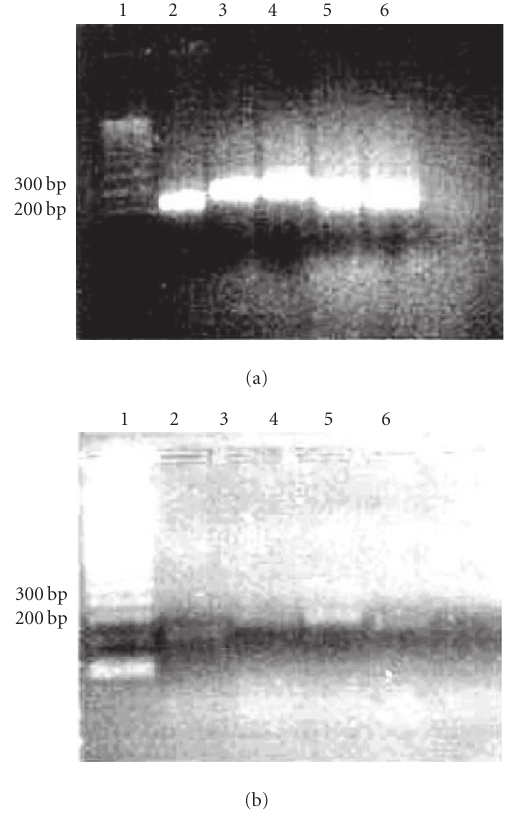
Figure 1. (a) RT-PCR amplification of the V β subsets in psori- atic patients. Lane 1: 100-bp ladder, lane 2: V β 2, lane 3: V β 5 . 1, lane 4: V β 8, lane 5: V β 12, lane 6: V β 14, (b) RT-PCR amplifi-